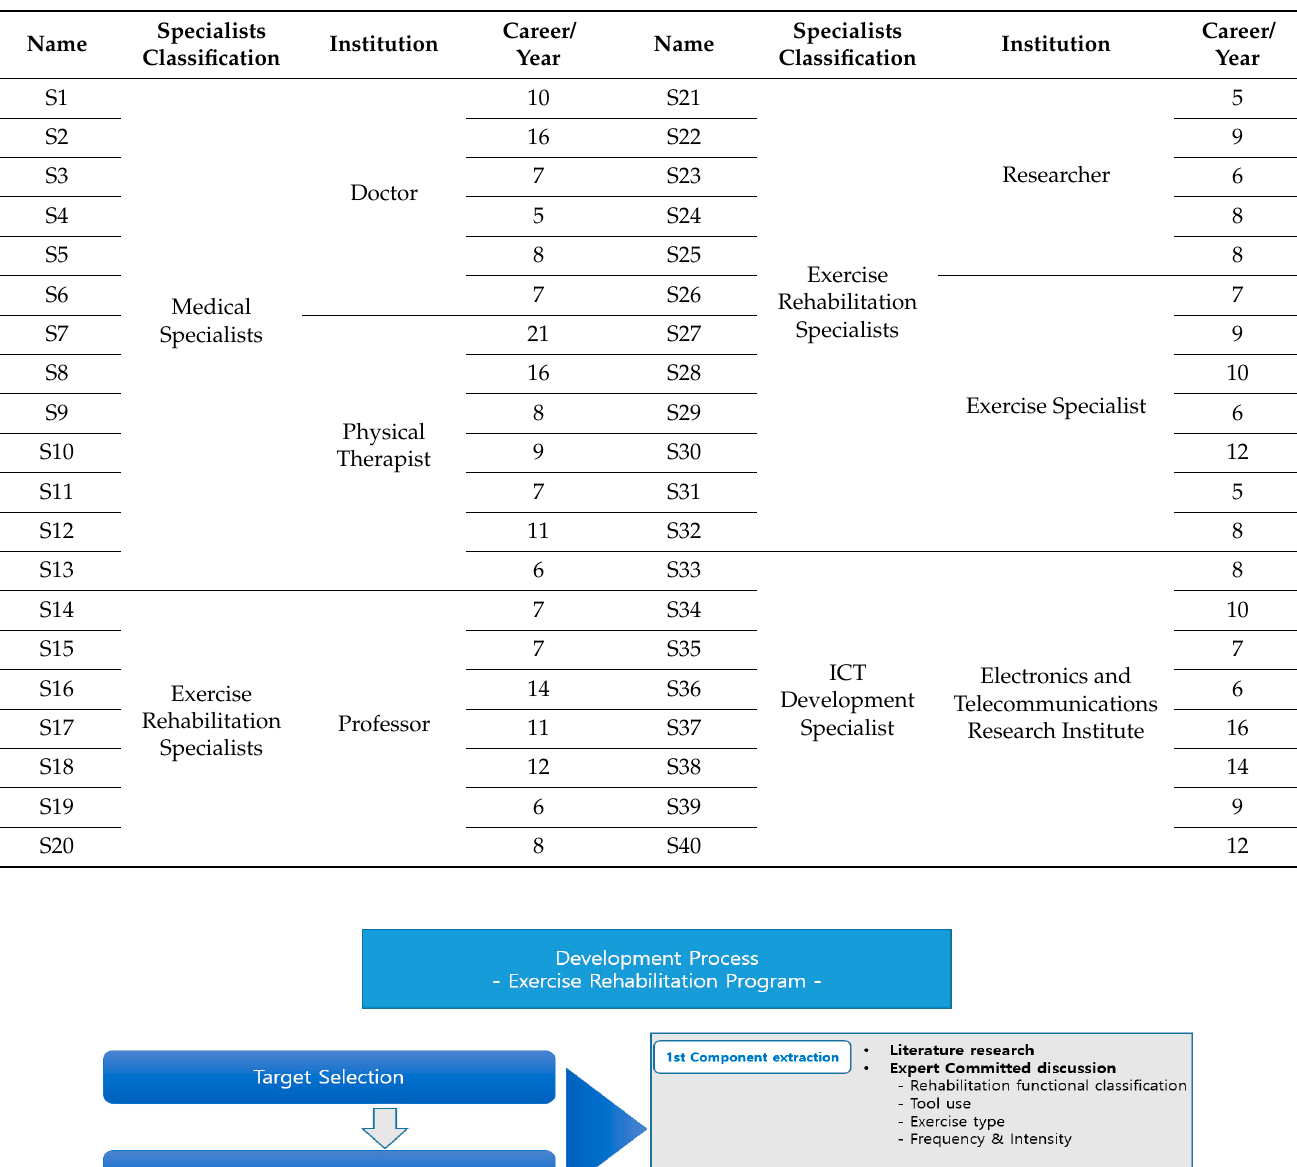
Table 1. Focus group interview (FGI) characteristics.